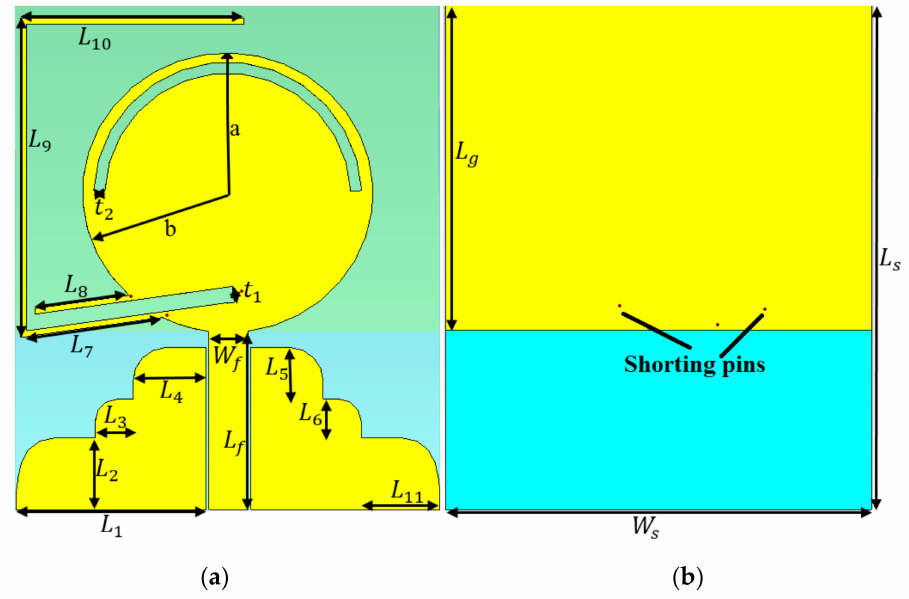
Figure 1. The proposed antenna’s simulated prototype: ( a ) front view and ( b ) ground